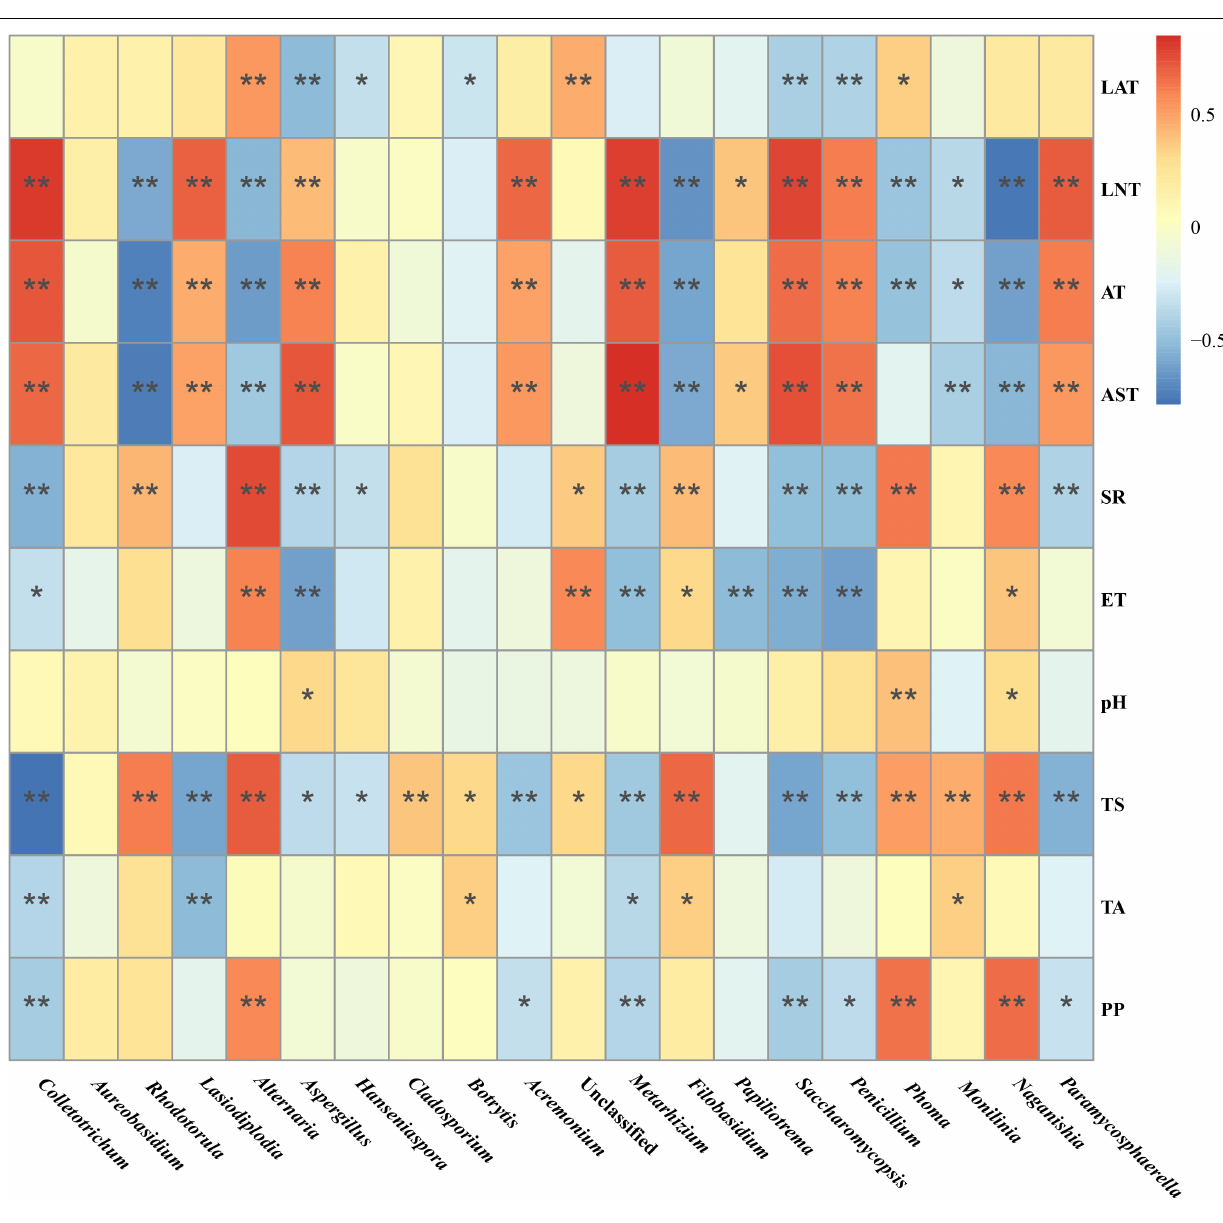
FIGURE 6 | Spearman correlation analysis of the correlation between the major fungi abundance in the Marselan must and various environmental factors. The different color intensities represent the degree of correlation. “*”, significant ( P < 0.05); “**”, extremely significant ( P < 0.01). Factors abbreviations: latitude (LAT), longitude (LNT), altitude (AE), average temperature (AT), average soil temperature (AST), solar radiation (SR), evaporation capacity (ET), pH, total sugar (TS), total acid (TA), and polyphenol